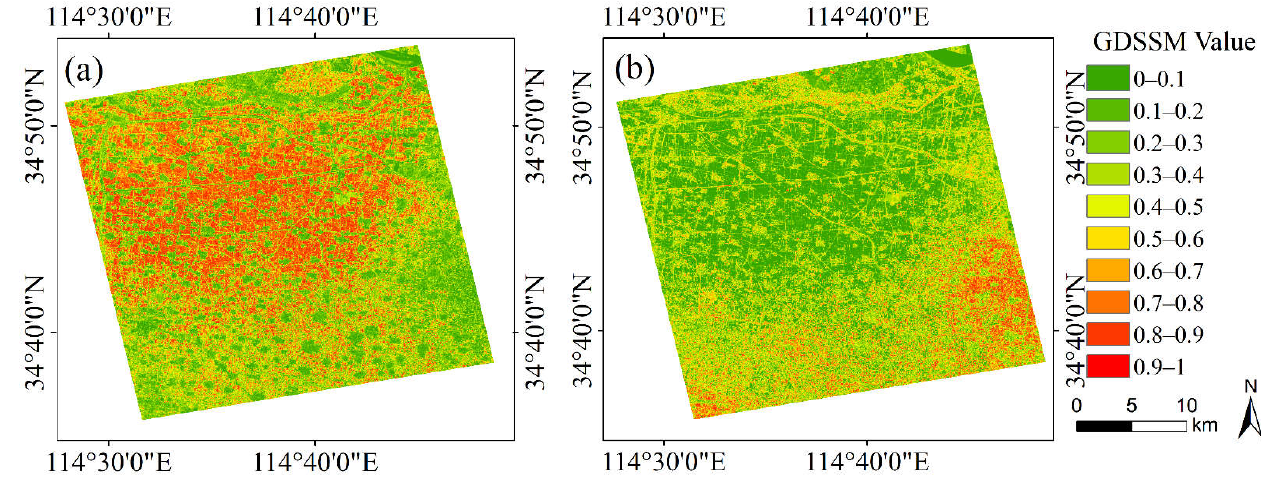
Figure 6. GDSSM value images of study area for ( a ) winter wheat sample and ( b ) garlic sample.